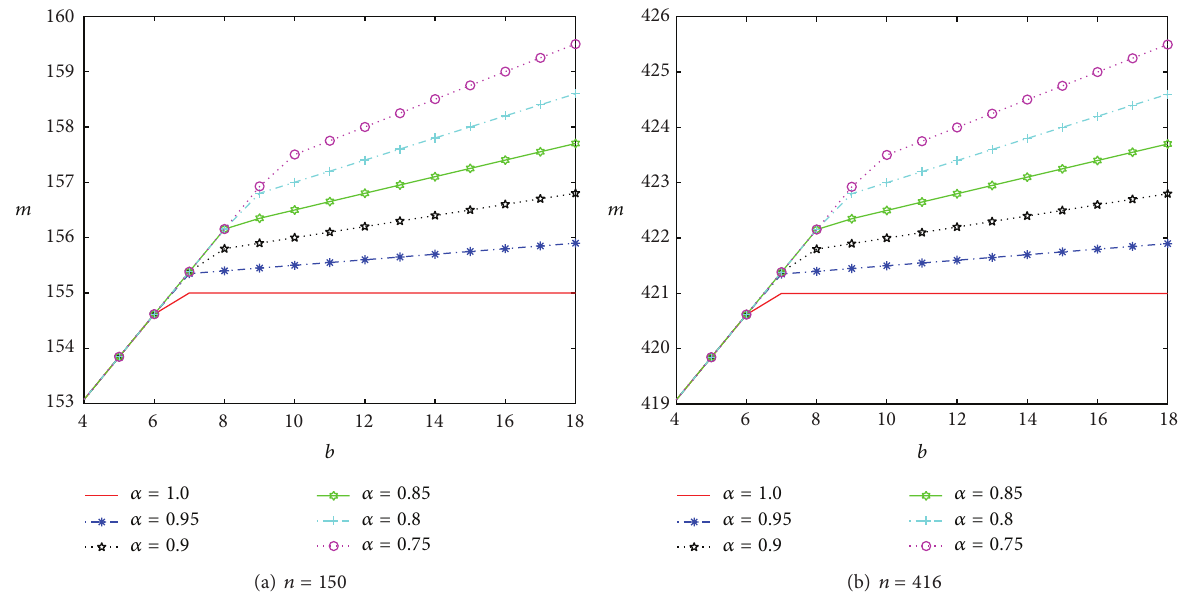
Figure 3: Optimal booking limit 𝑚 ∗ under the changes of 𝛼 and 𝑏 when 𝛽 = 0.8, 𝑗 = 5 .